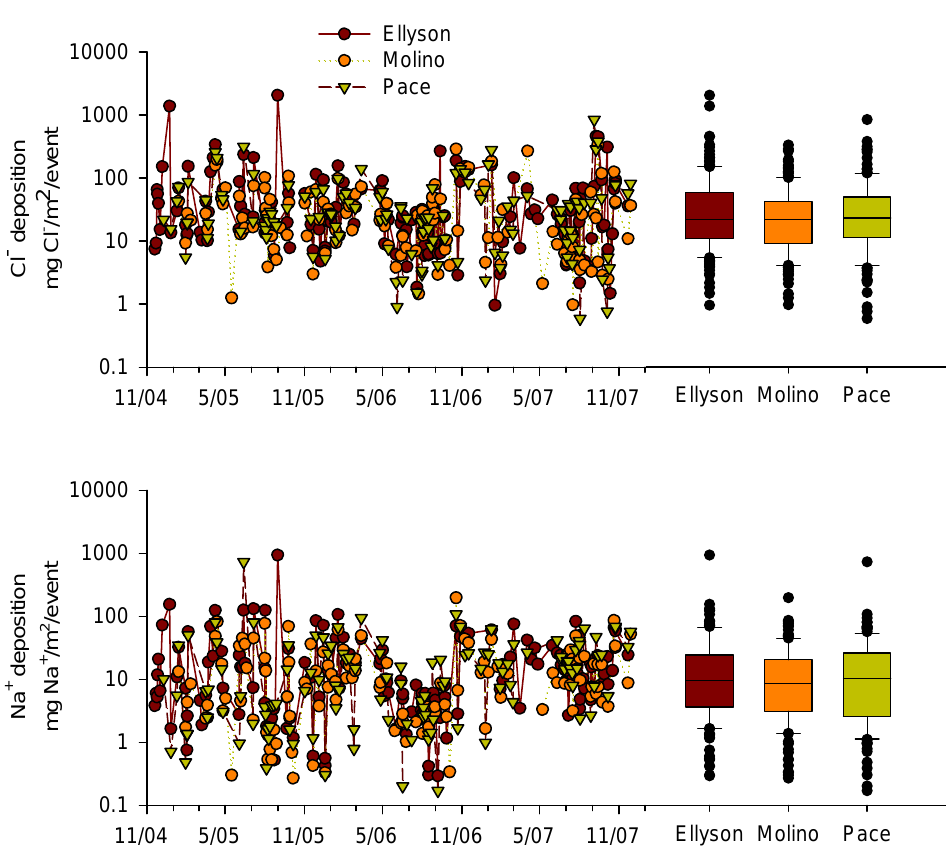
Fig. 5. Chloride (Cl − ) deposition (mg/m 2 /event) (top panel) and sodium (Na + ) deposition (mg/m 2 /event) (bottom panel) as in Fig. 3.